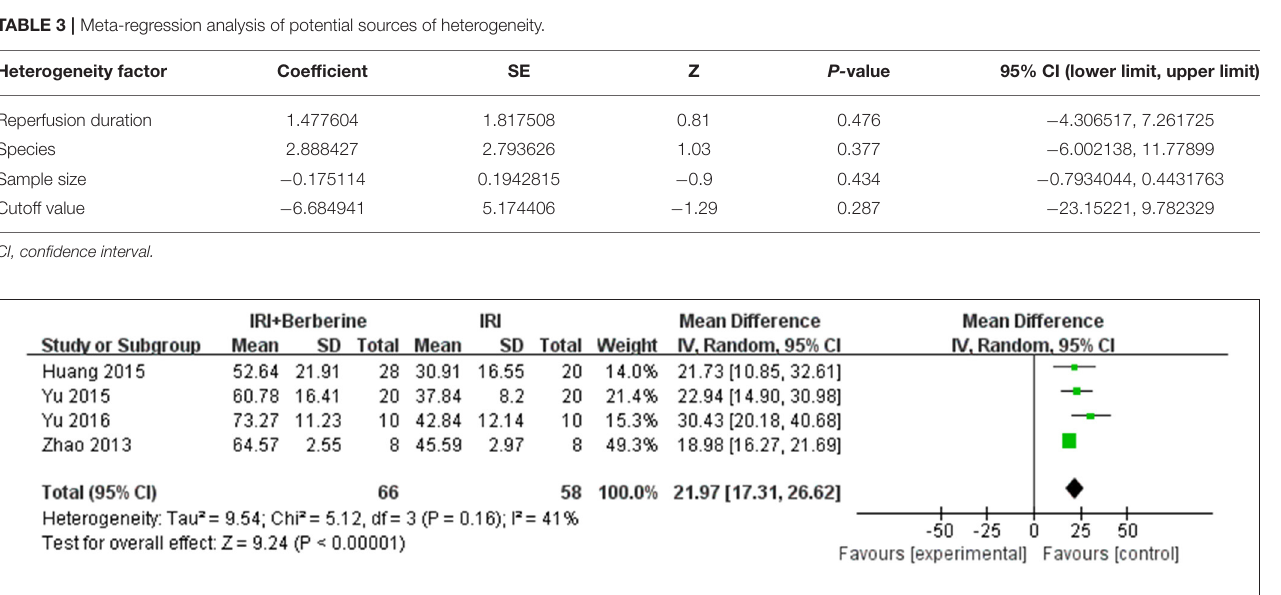
FIGURE 5 | Forest plot showing the effects of BBR on increasing LVEF compared to the control